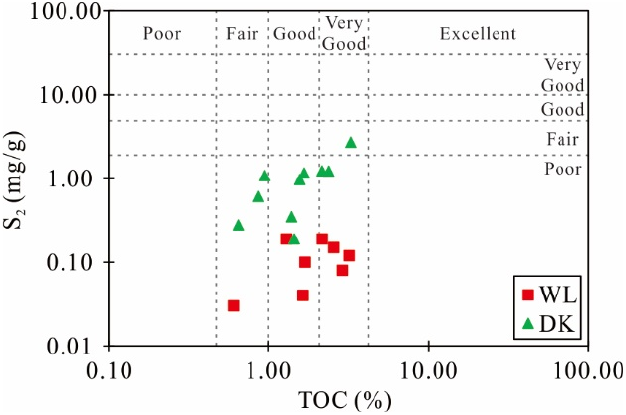
Figure 6. Cross-plot of S2 and TOC for determining the quality of source rocks. The relationship between the TOC and distance from the granite porphyry dike shows a progressive decrease in TOC toward the magmatic intrusion, before undergoing a reversal (Figure 7a). A significant decrease in TOC values in source rocks heated by magmatic intrusions is common in other examples due to the destructive effect on the organic matter by the intrusive heating, as in the DK samples [9,66,67]. By contrast, the TOC values, in which WL samples increase with the distance to the granite porphyry dike, decrease. This phenomenon may be related to the fact that the magmatic-hydrothermal activities in the Wolong area is conducive to the enrichment and preservation of organic matter. According to the relationship between the Rock-Eval pyrolysis parameters and the distance to the granite porphyry dike, when the distance from the source rock to the granite porphyry dike decreases, the hydrocarbon generation potential and HI decrease gradually (Figure 7b,c). The phenomenon is consistent with previous reports [18,22]. Rock-Eval results support the assumption of the high thermal stress and destruction of hydrocarbons within the thermal aureole, especially for WL samples, which are closer to the granite porphyry dike.